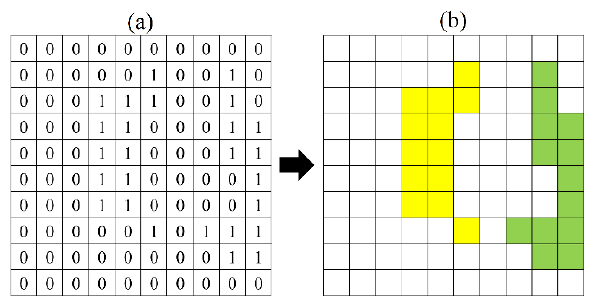
Figure 2. An example of how a mask will be labelled. (a) . Mask (b) . Labelled mask